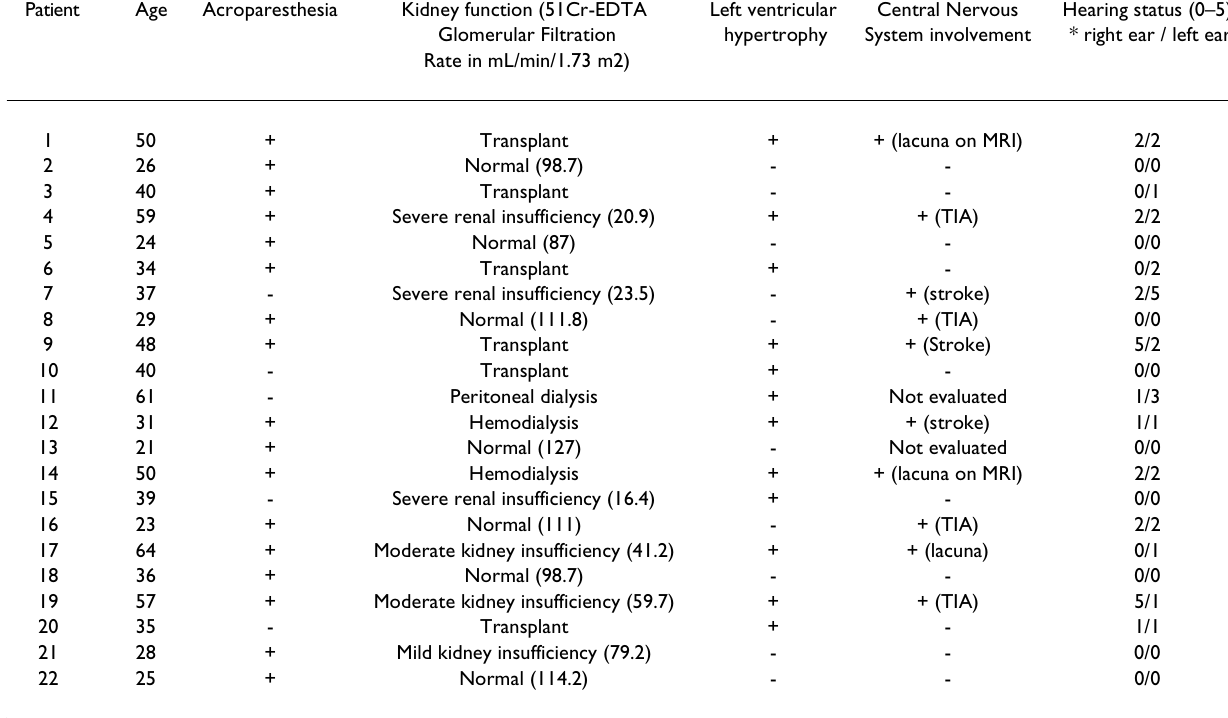
Table 1: Demographics and clinical characteristics of the study population